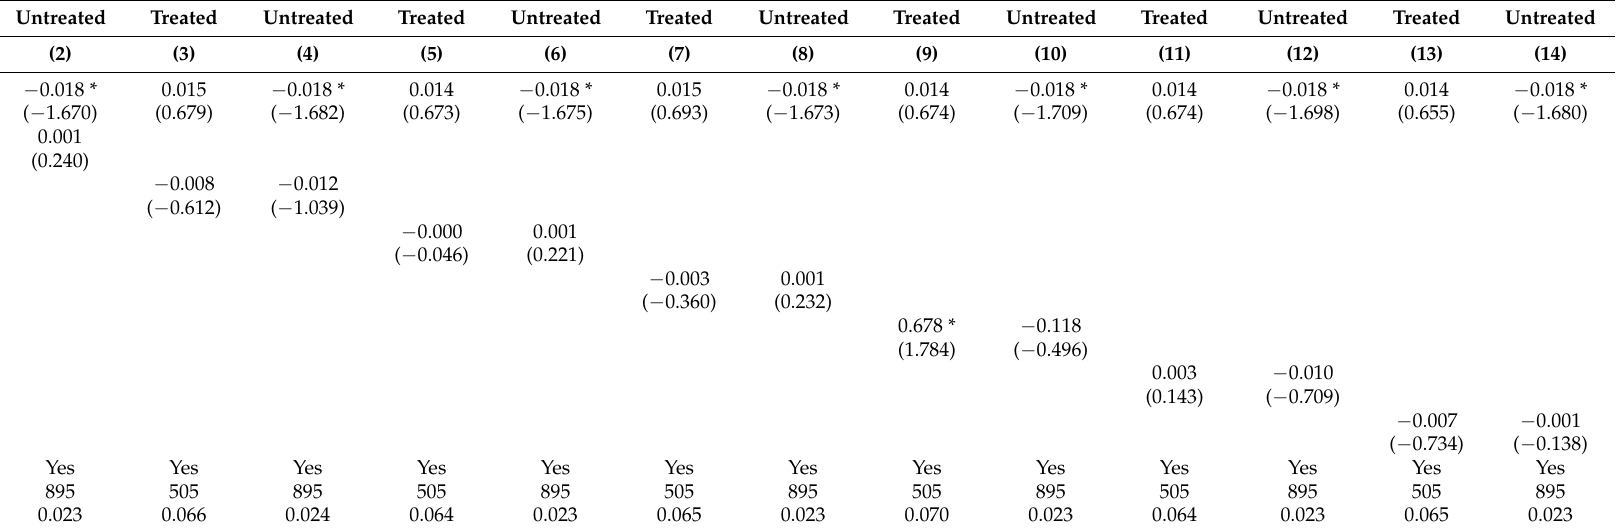
Table 4. The promotion mechanism